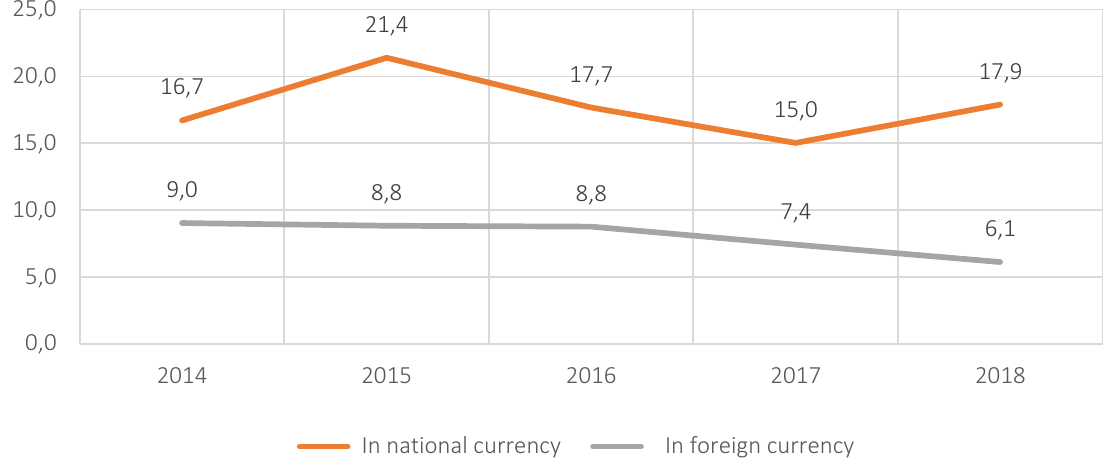
Figure 7. Weighted average interest rates for non-financial corporations by currency type for 2014–2018,